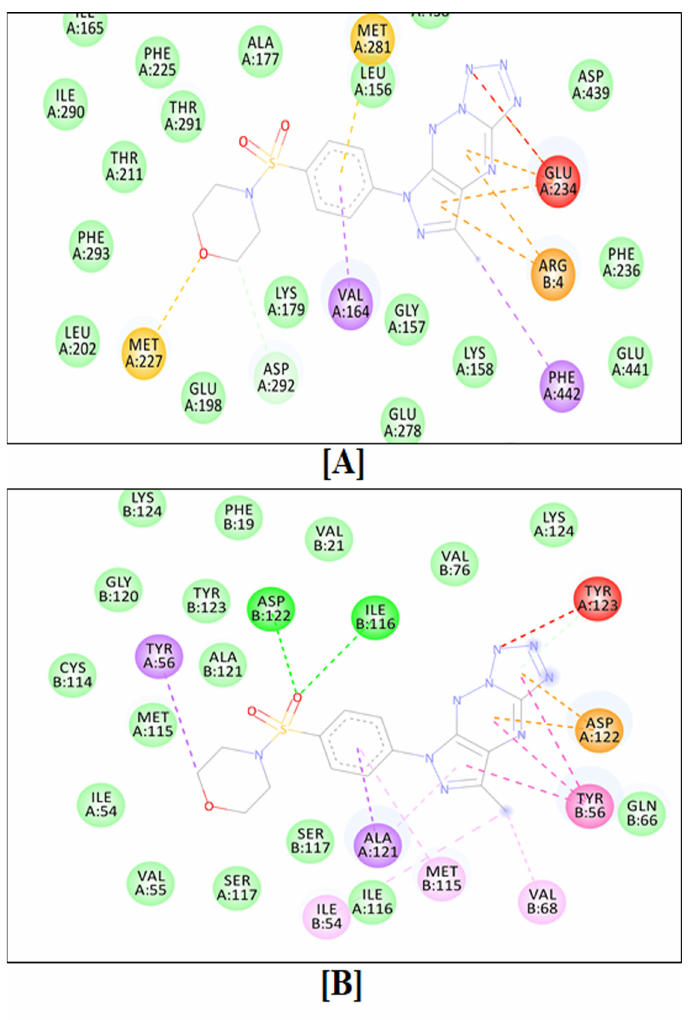
Figure 12. Two-dimensional binding interactions of the triazine sulfonamide analog MM136 against human AKT1 ( A ) and PD-L1 ( B